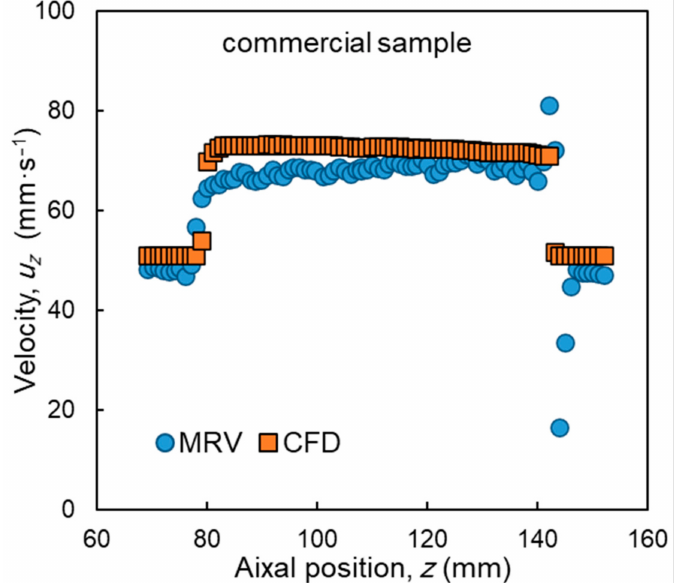
Figure 5. The radially averaged axial velocity u z in CFD simulations and MRV measurements for the flow rate 1.5 SL · min − 1 within the commercial ceramic